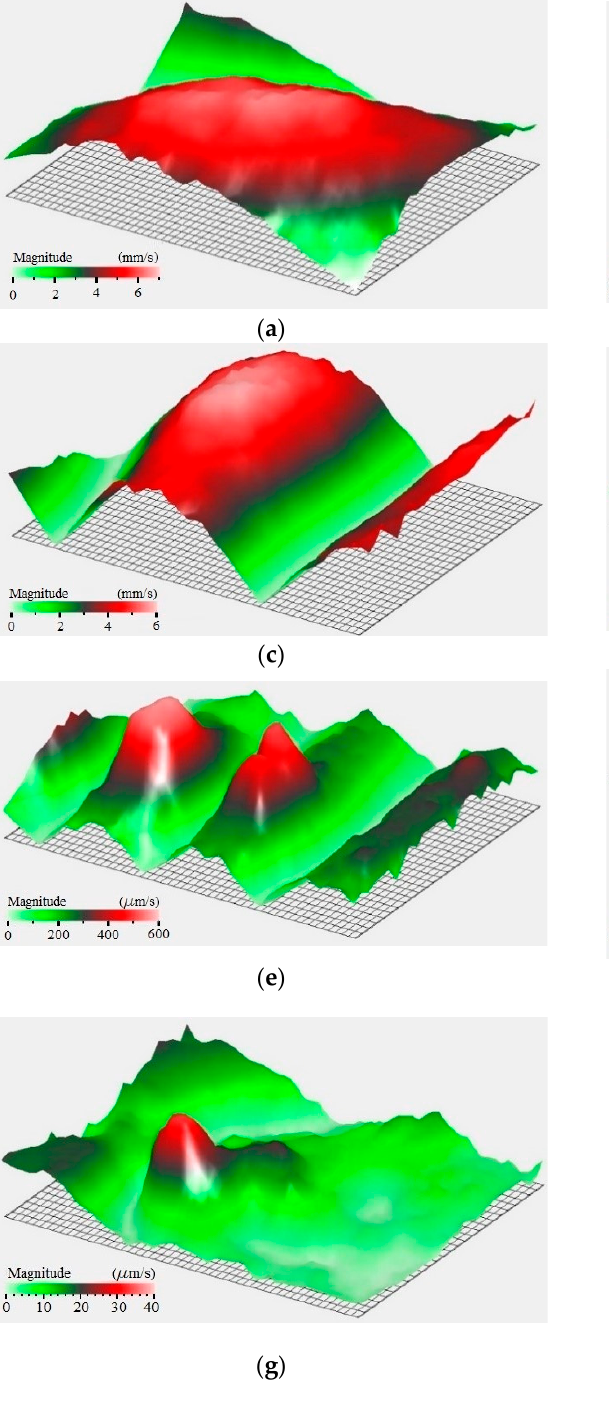
Figure 11. Characterizing impact damage in 1.1 mm thick CFRP sample under broadband excitation: ( a ) 1.75 kHz; ( b ) 2.25 kHz; ( c ) 4 kHz; ( d ) 10.6 kHz; ( e ) 13 kHz; ( f ) 27.2 kHz; and ( g , h ) 28.9 kHz.